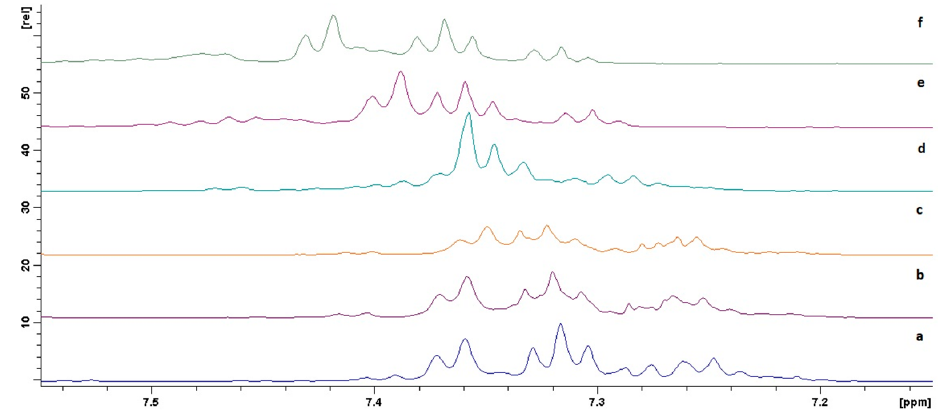
Figure 4. The 1 H NMR spectra in acetonitrile solutions for free ligand L-spectrum ( a ) and after adding silver ions with the Ag:L molar ratio 0.5:1, 1:1, 2:1, 3:1, and 4:1-spectra ( b ), ( c ), ( d ), ( e ), and ( f ), respectively.